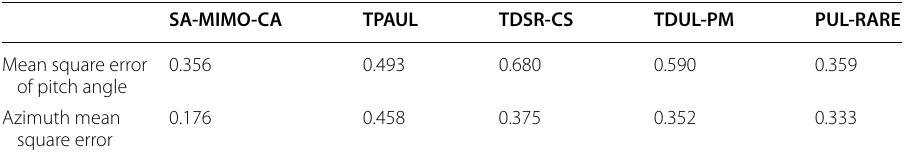
Table 3 The relationship between the SNR of the elevation angle and the azimuth angle and the mean square error (when the SNR is